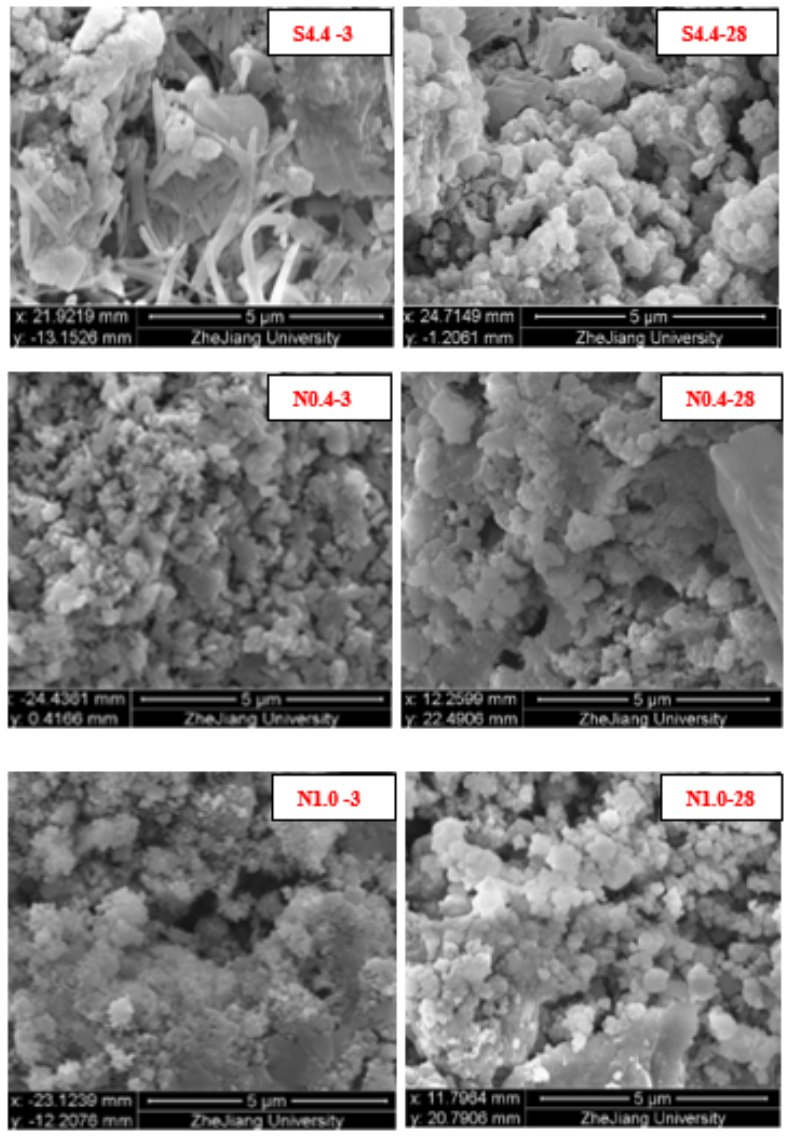
Figure 15: SEM images of S4.4, N0.4 and N1.0 at 3 and 28